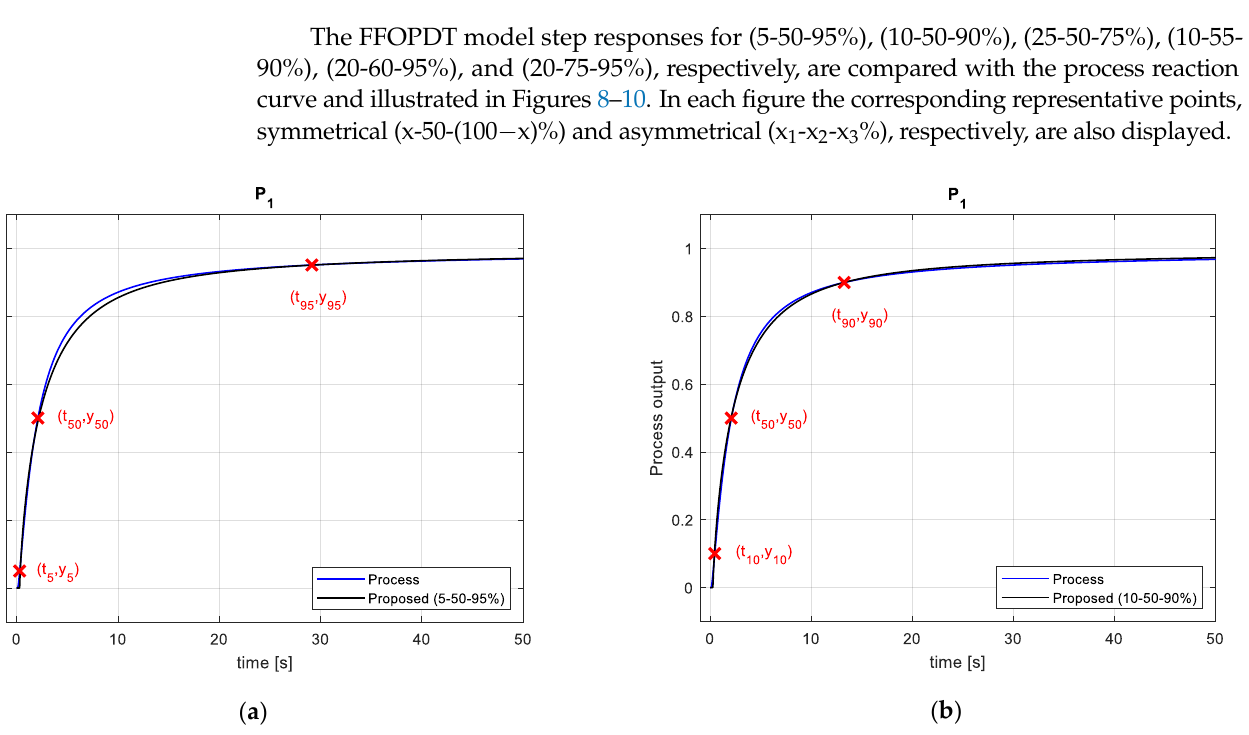
Figure 8. FFOPDT model step response using the proposed identification method for process P 1 and process reaction curve: ( a ) Symmetrical set of points (5-50-95%); ( b ) Symmetrical set of points (10-50-90%).